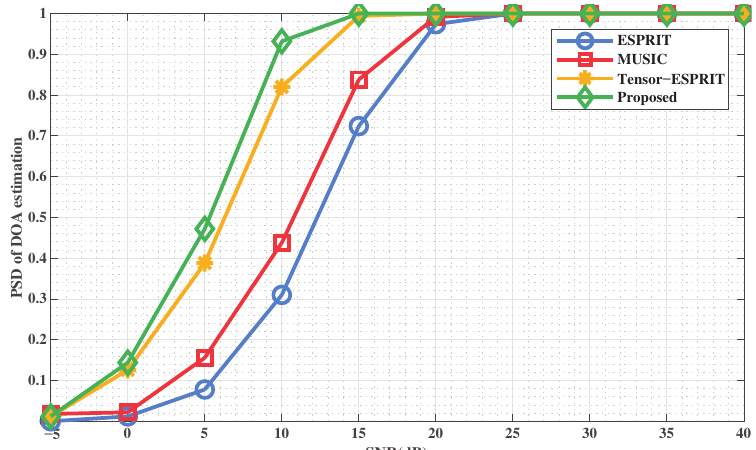
Figure 9. PSD of DOA estimation versus SNR